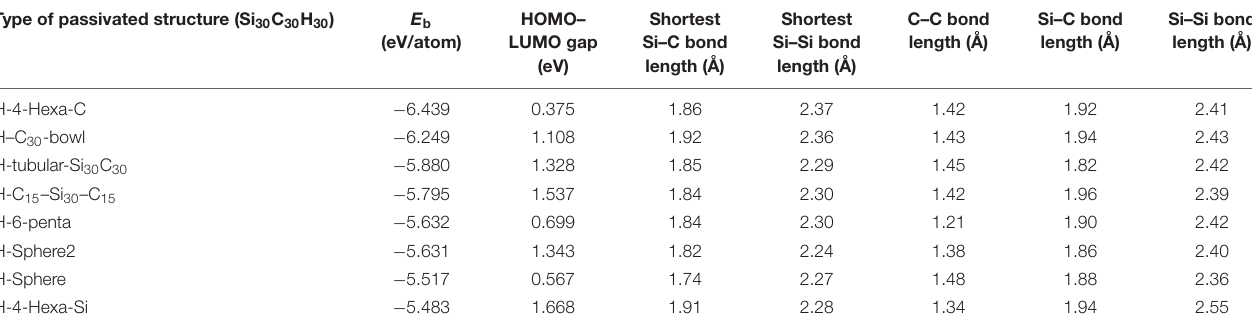
Frontiers in Materials |